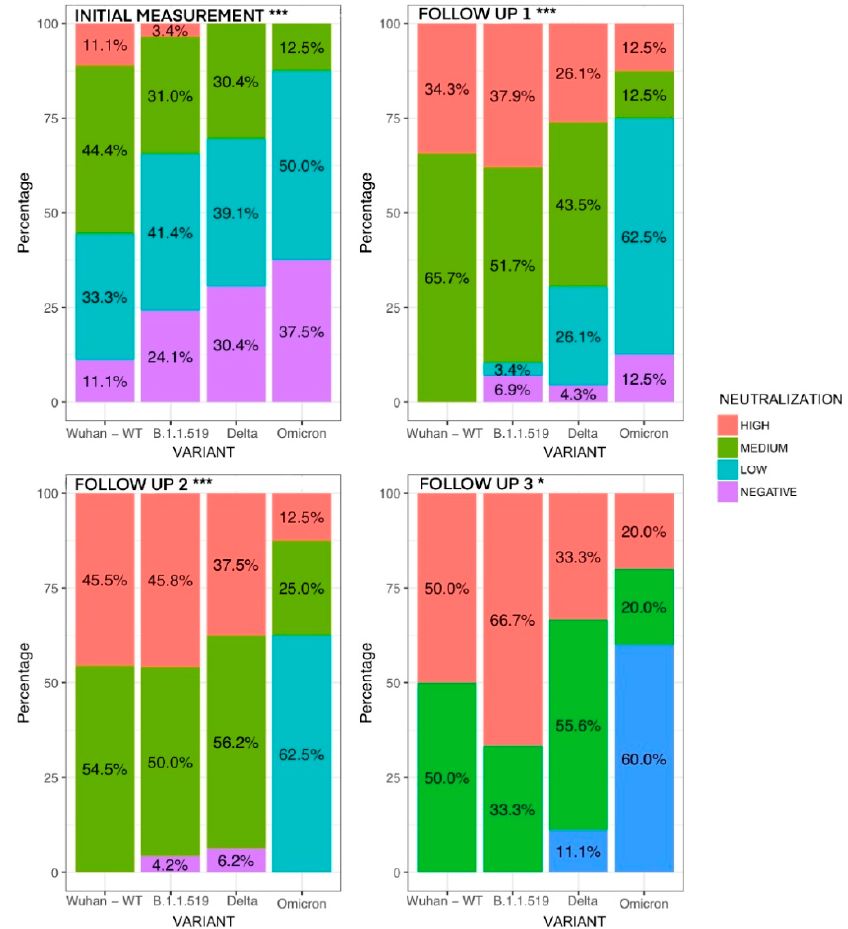
Figure 6. Proportion of patients in each neutralization category barplot collage with four panels, one panel for each of the longitudinal measurements showing the proportion of patients classified according to the following neutralization categories: 0–30% negative production, 31–60% low production, 61–90% medium production, and >90% high production of each viral lineage (Wuhan-WT, B.1.1.519, and VOC Delta). Initial measurement represents a period of <14 days post-symptom onset, follow-up 1 to the period between 14 and 21 days post-symptom onset, follow up-2 to the period between 22 and 30 days post-symptom onset, and follow-up 3 the last measurement (30 days post-symptom onset). * = p < 0.05, *** = p <